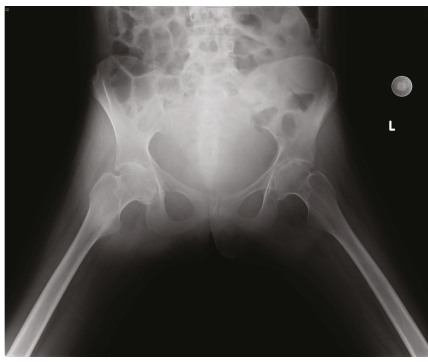
Figure 1: Plain hip radiographs at age 19.